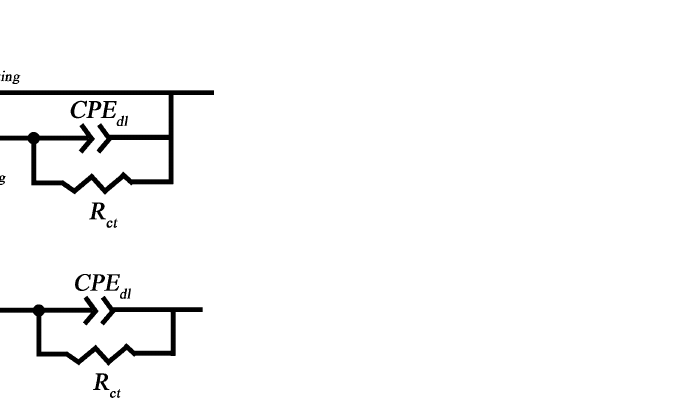
Figure 13. Bode EIS plots of ( a ) PDC/Ce-HT, ( b ) SMV/Ce-HT and ( c ) AS/Ce-HT specimens after 3 h, 24 h and 72 h immersion in 3.5 wt% NaCl solution.